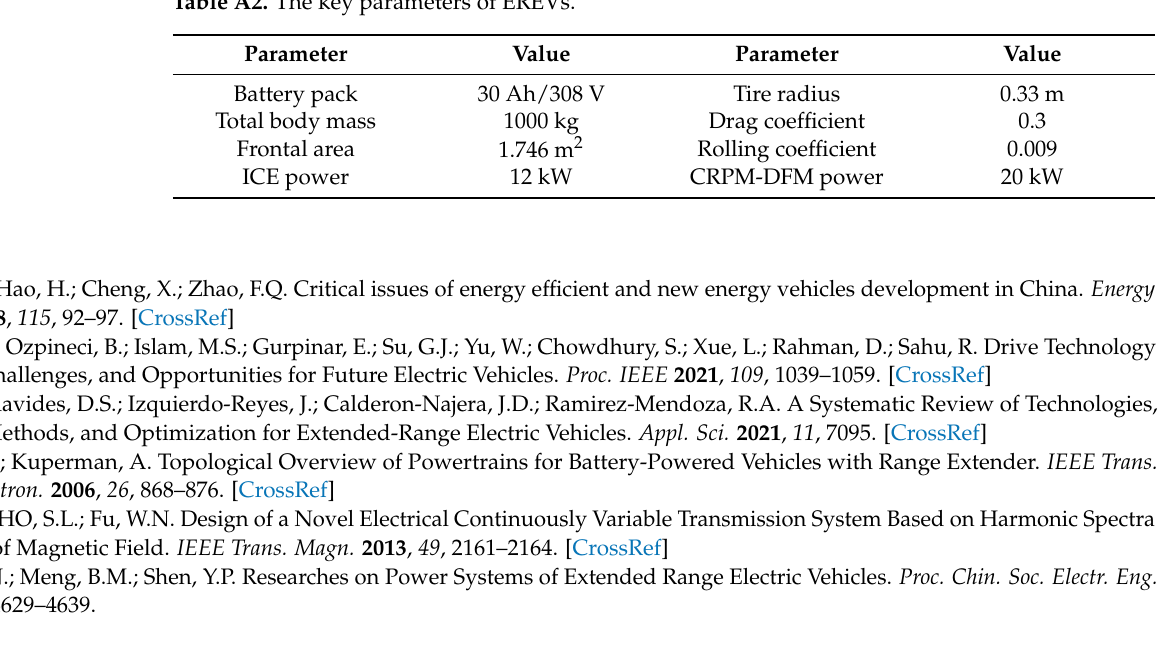
Table A2. The key parameters of